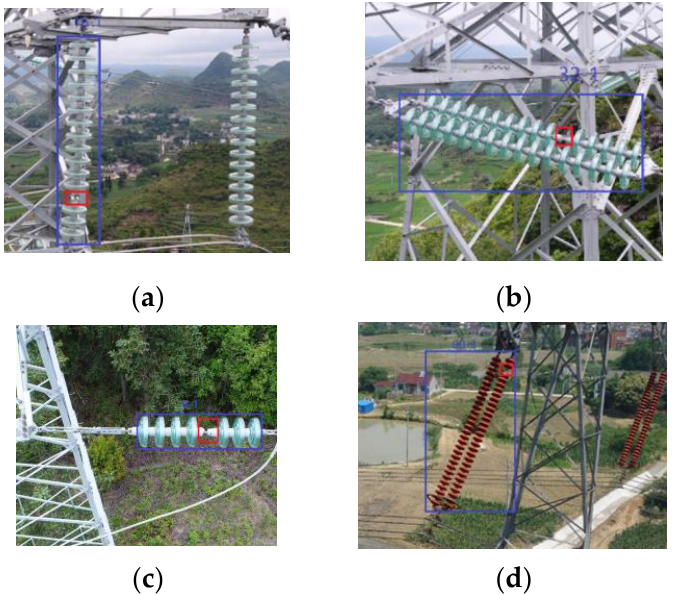
Figure 13. Missing insulator cap detection. ( a ) Glass insulator with 1 * 16 installation, ( b ) glass insulator with 2 * 16 installation, ( c ) glass insulator with 1 * 8 installation, ( d ) porcelain insulator